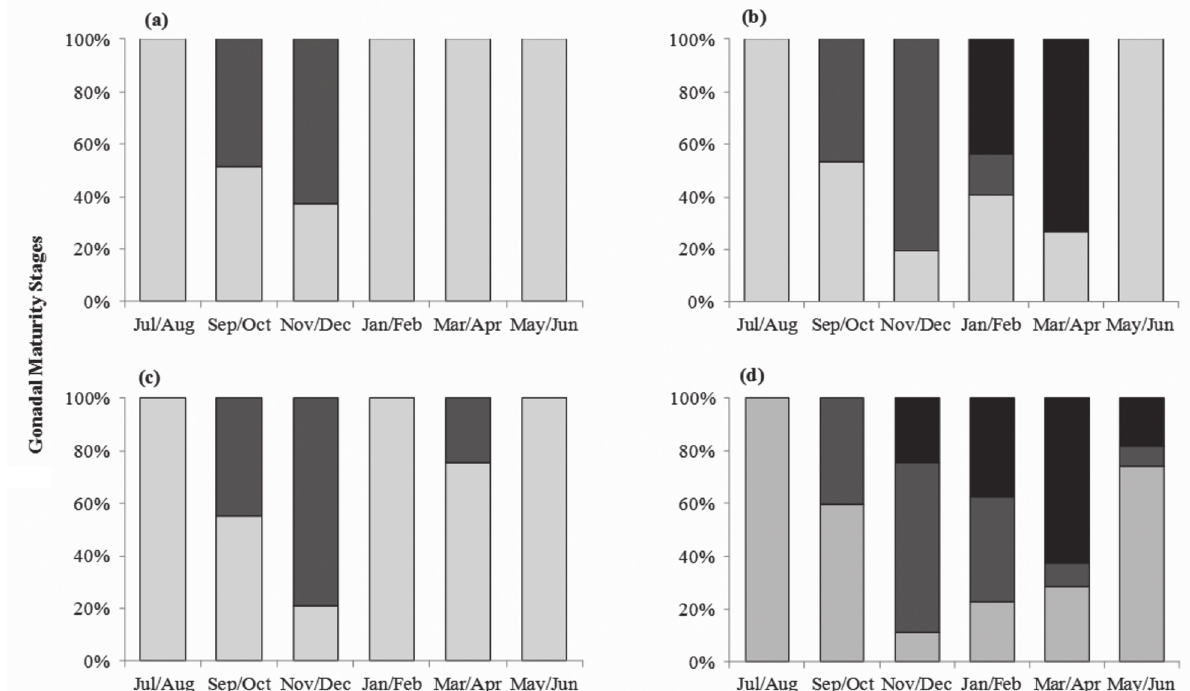
Fig. 4. Relative frequency of maturity stages of Brycon orthotaenia captured in two sites of the rio São Francisco, downstream from the Três Marias Dam. (a) females from site 1, (b) females from site 2, (c) males from site 1 and (d) males from site 2. Resting, light gray; maturing/mature, dark gray; spawning/spent, black. Table 2. Bimonthly and total sex ratio of Brycon orthotaenia females and males captured in two sites of upper rio São Francisco, downstream from the Três Marias Dam. * Indicates the significant values for sex ratio (Chi-square, P < 0.05, χ 2 = 3.84, df = 1).